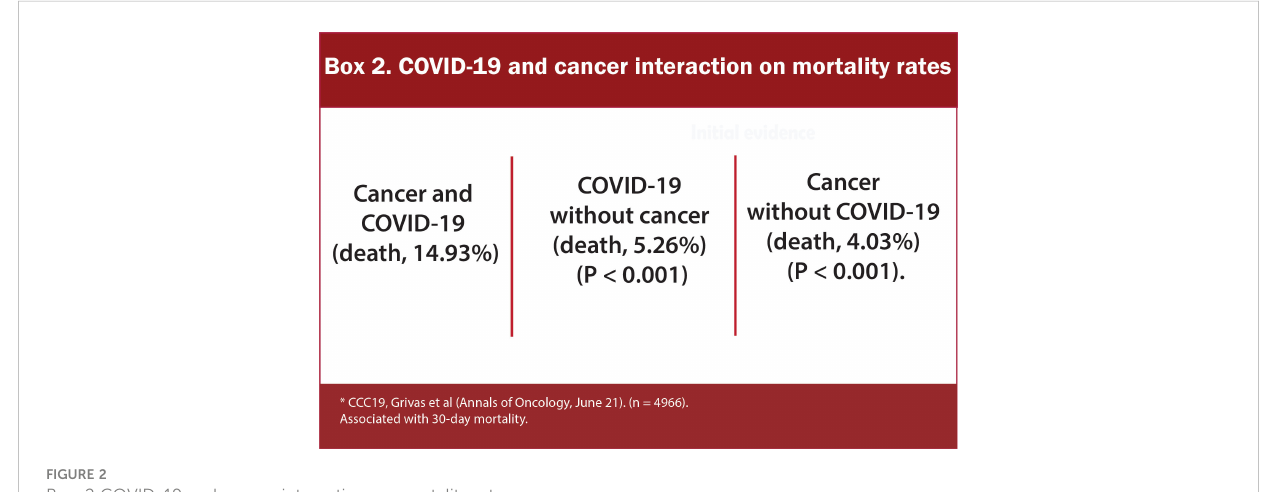
FIGURE 2 Box-2 COVID-19 and cancer interaction on mortality